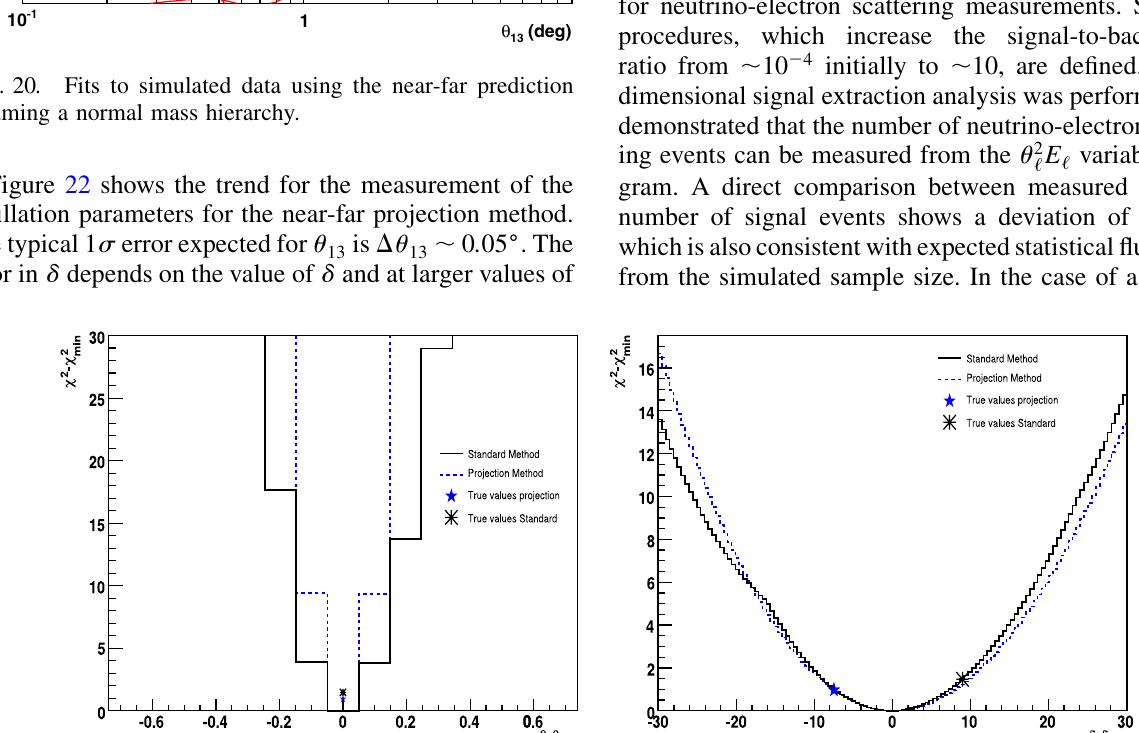
FIG. 21. Projection of the minimum (cid:12) 2 onto the (cid:1)